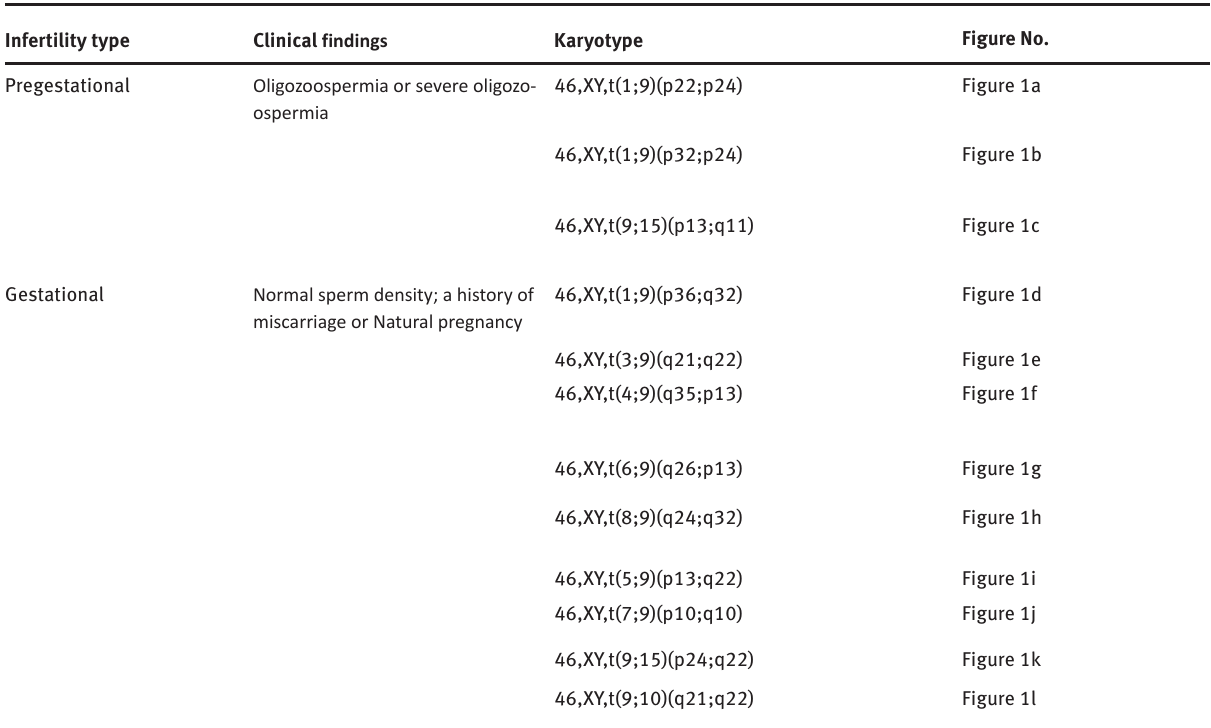
Table 1: Karyotypes of chromosome 9 translocation carriers and their clinical